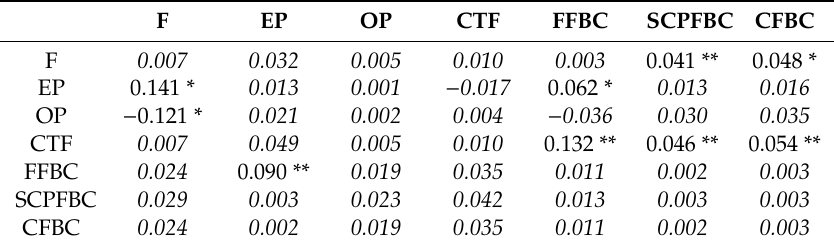
Table 5. Results of indirect e ff